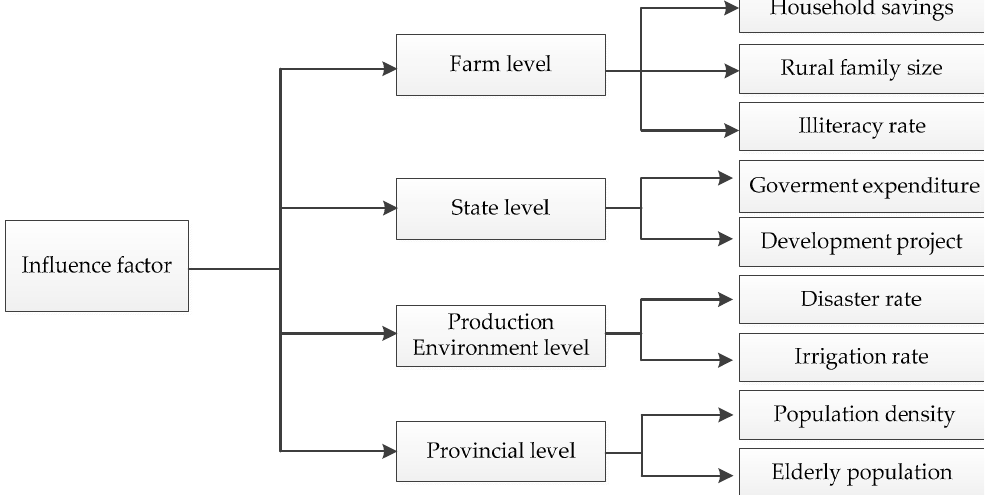
Figure 1. Indicators to identify determinants of total-factor productivity (TFP), technical efficiency (TE), and technical efficiency change (EC).